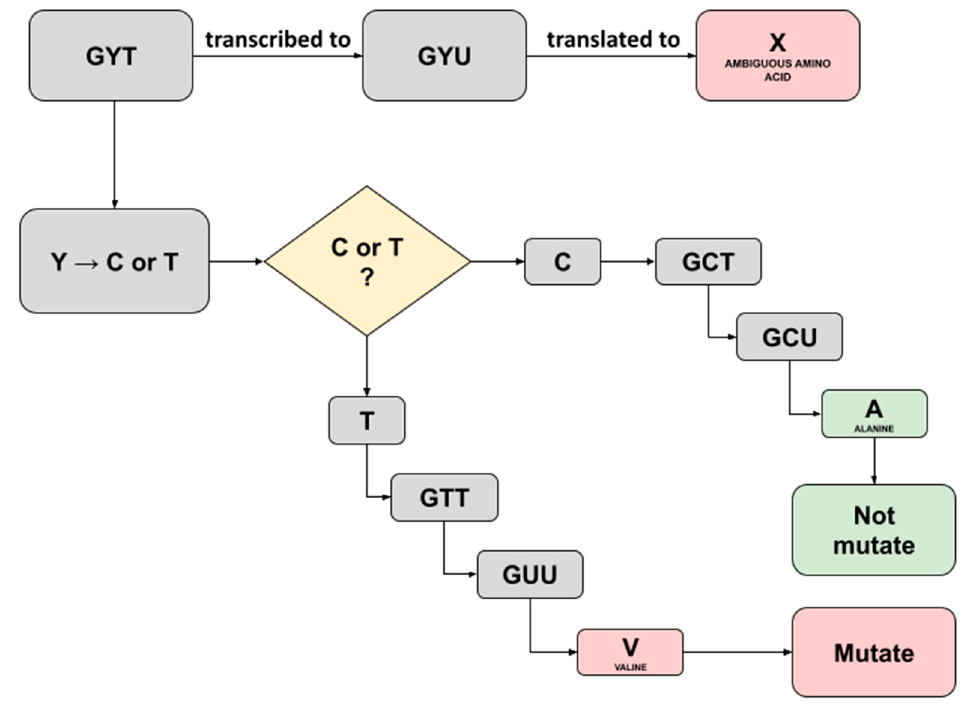
Figure 4. Illustration depicting the possible translation result of ambiguous amino acid X detected in Sample C5 running both Normal Pipeline and Fast Pipeline. An X amino acid was detected at position 54 region NS3-ORF3A.